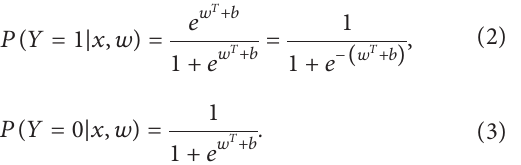
Figure 2: Classification model